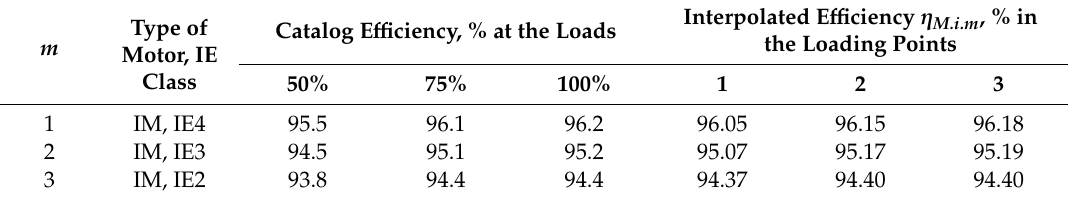
Table 3. Catalog and interpolated e ffi ciencies of 75 kW 4-pole electric